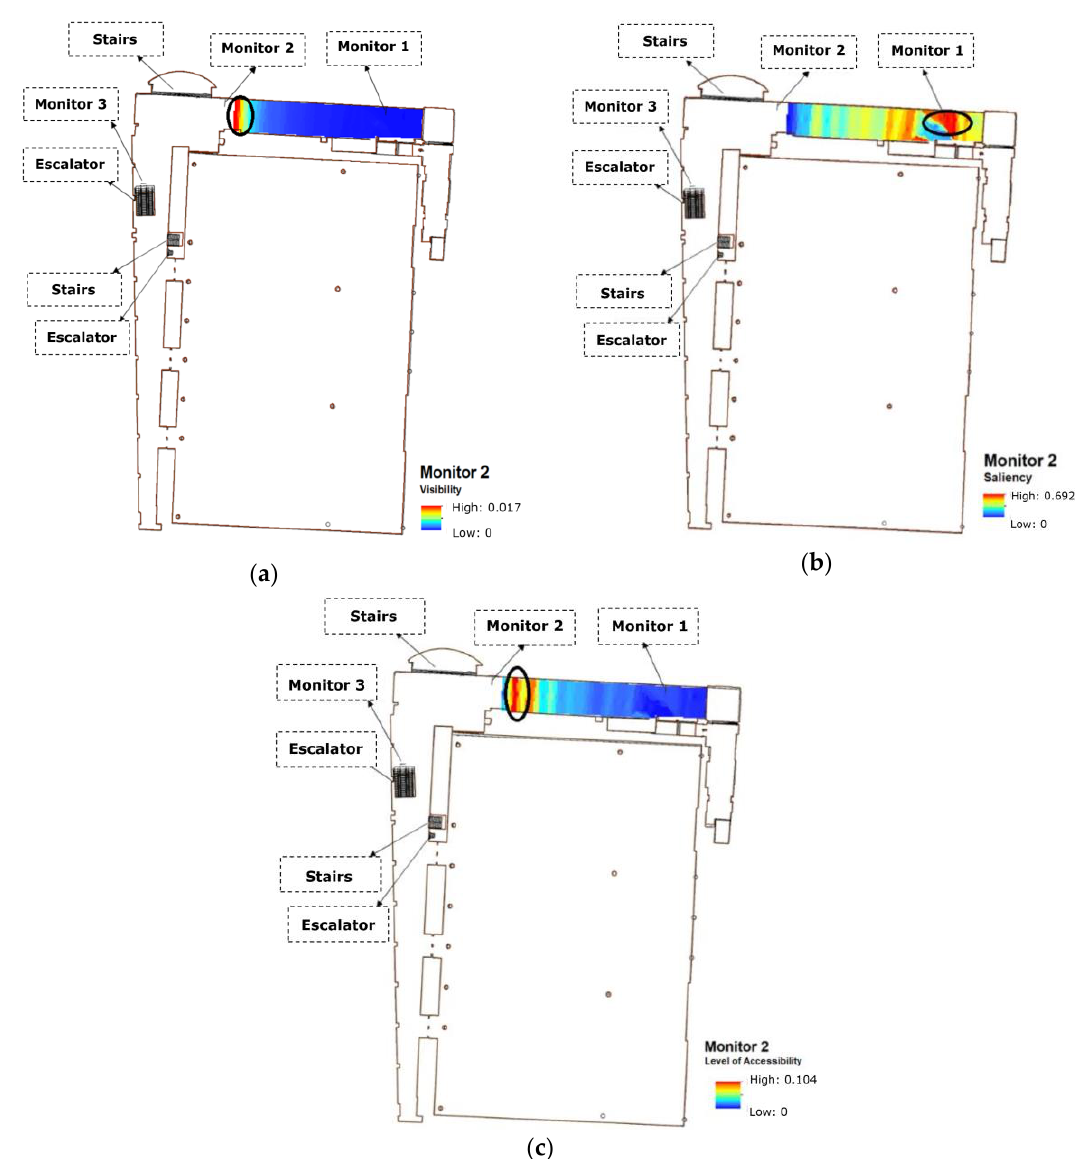
Figure 13. ( a ) Visibility, ( b ) visual saliency, and ( c ) accessibility level of monitor 2.